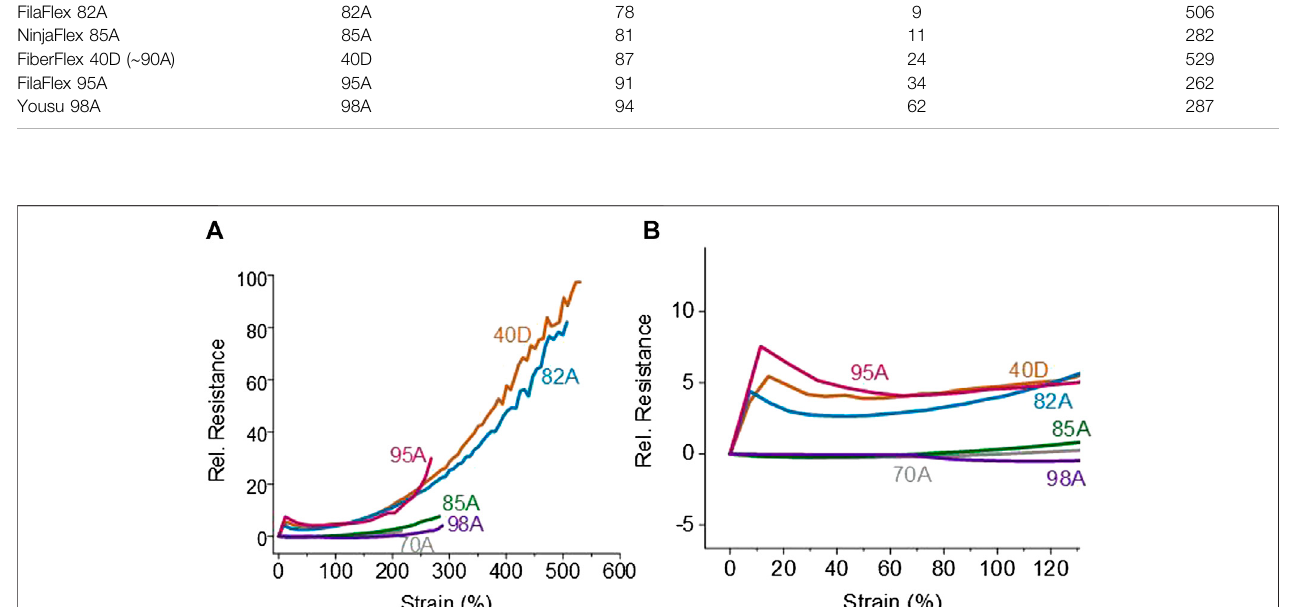
FIGURE 3 | Relative resistance – strain curve for the 3D-printed TPU strips with in situ integrated sensing elements using TPU fi laments with different Shore hardnesses. (FilaFlex 70A, 82A, 95A, and 40D; NinjaFelx 85A; Yousu 98A) (A) up to the point of fracture and (B) close-up at strains up to 130%.